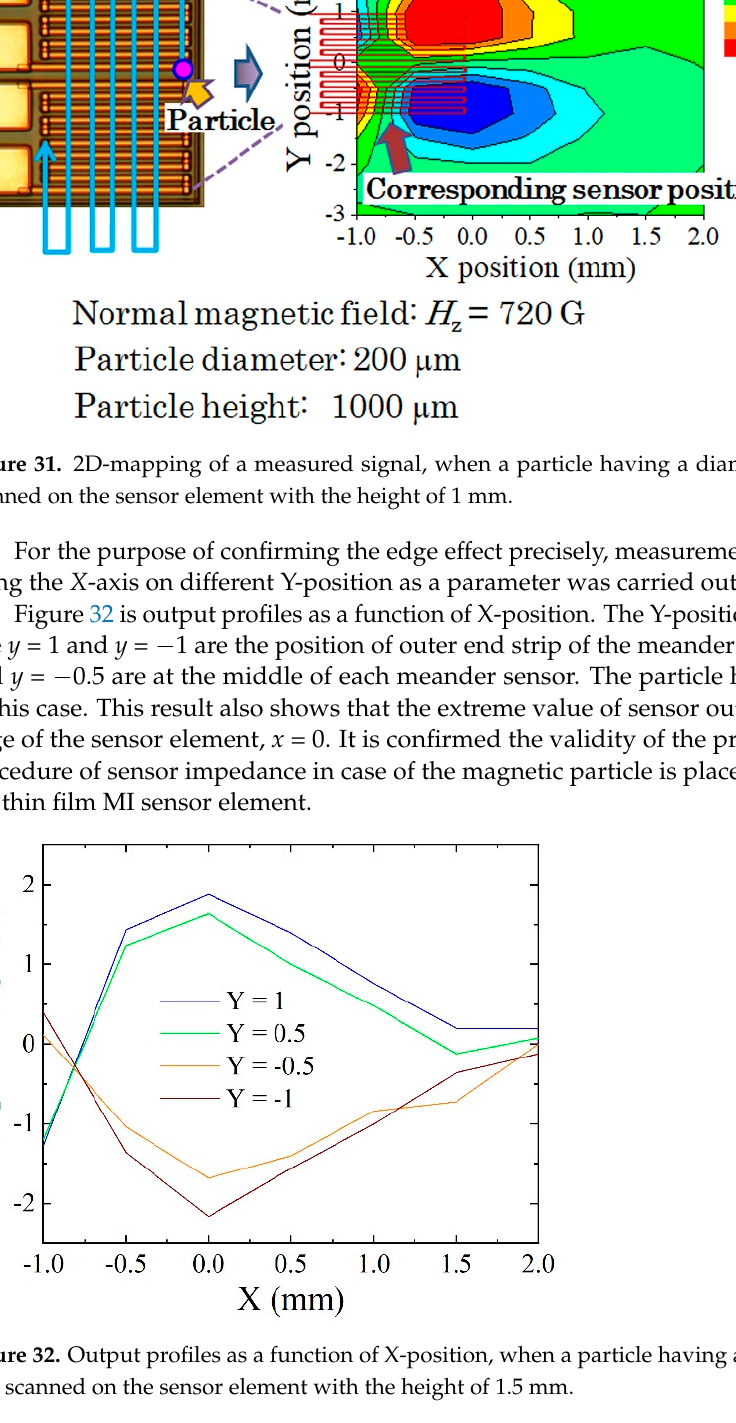
Figure 32. Output profiles as a function of X-position, when a particle having a diameter of 200 µ m was scanned on the sensor element with the height of 1.5 mm.